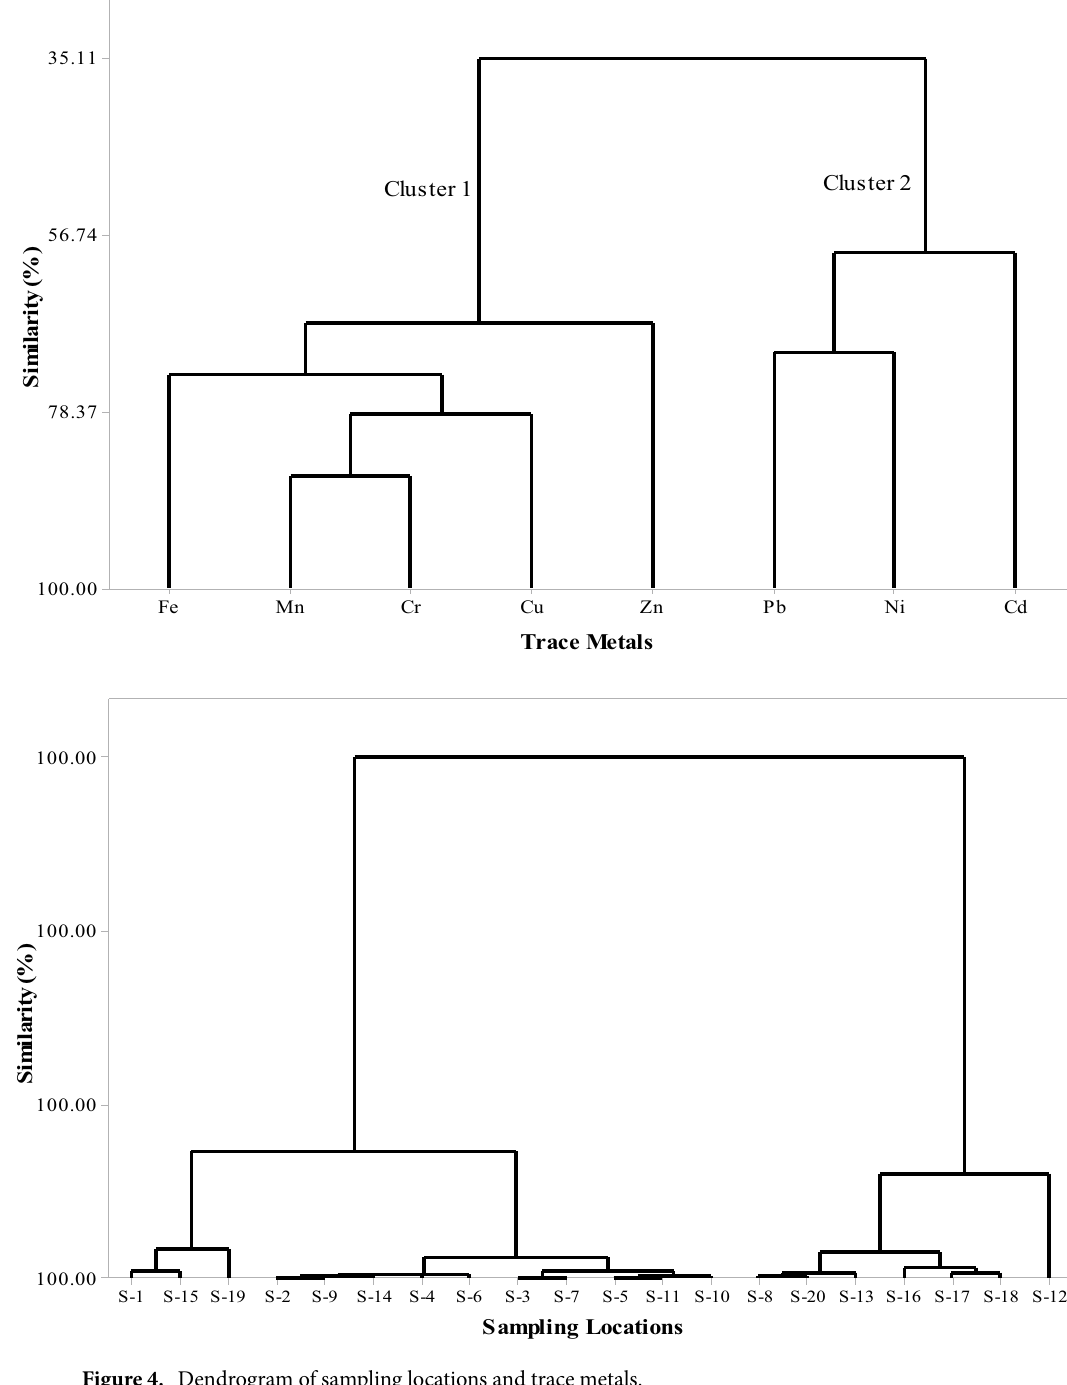
Figure 4. Dendrogram of sampling locations and trace